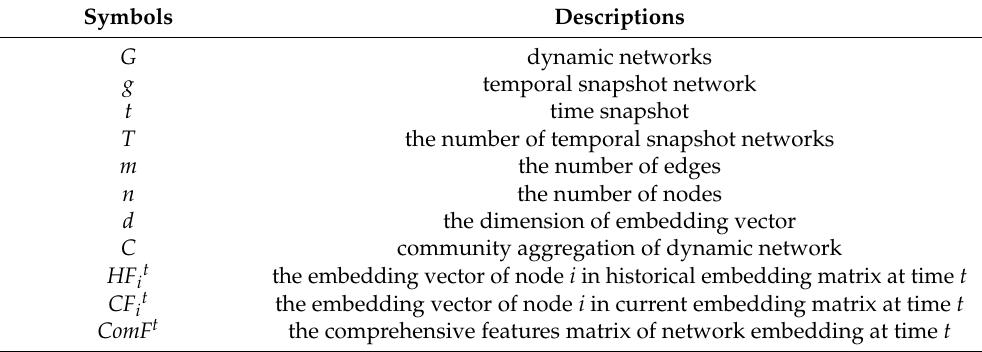
Table 1. Symbols and descriptions. Symbols Descriptions